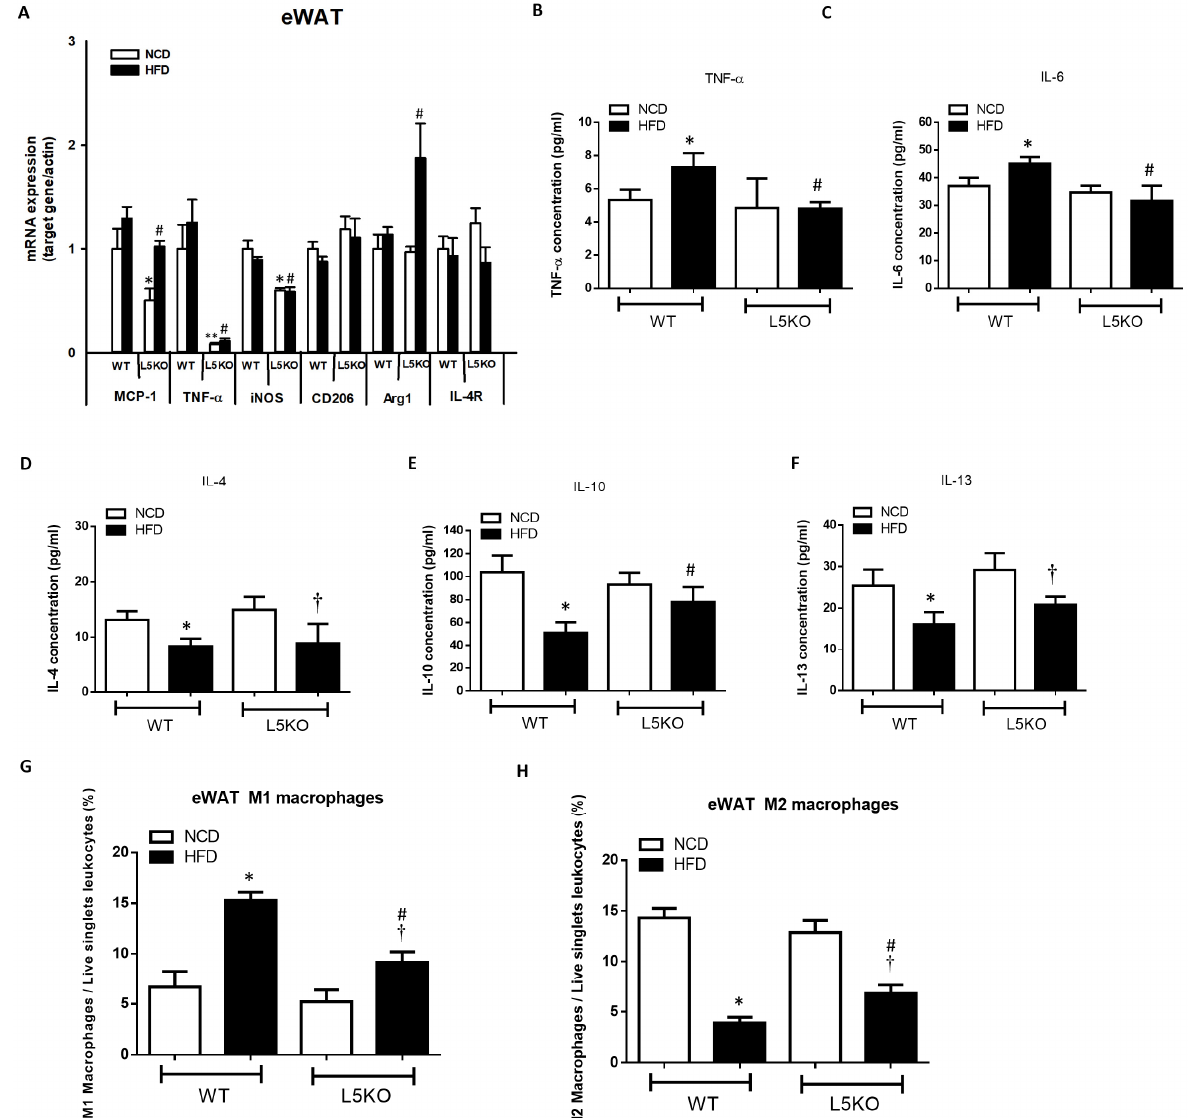
Figure 2. CCL5 deficiency ameliorates M1 macrophage infiltration and inflammation in the eWAT of HFD-fed mice. ( A ) Gene expressions of the M1 macrophage markers MCP-1, TNF α , and iNOS, and the M2 macrophage markers CD206, Arg1, and IL-4R using total mRNA extracted from eWAT and qPCR analysis; adipose tissue protein content of ( B ) TNF- α , ( C ) IL-6, ( D ) IL-4, ( E ) IL-10, and ( F ) IL-13; ( G ) analysis of F4/80 + CD11c + CD206 − M1 macrophages in the SVCs of eWAT by flow cytometry; ( H ) analysis of F4/80 + CD11c - CD206 + M2 macrophages in the SVCs of eWAT by flow cytometry in CCL5KO and WT mice fed an NCD or HFD for 18 weeks. All data are presented as mean values ± SEM from at least 9 mice in each group. Statistical differences are indicated: *, p < 0.05; **, p < 0.001 vs. WT-NCD; #, p < 0.05 vs. WT-HFD; †, p < 0.05 vs. L5KO-NCD.